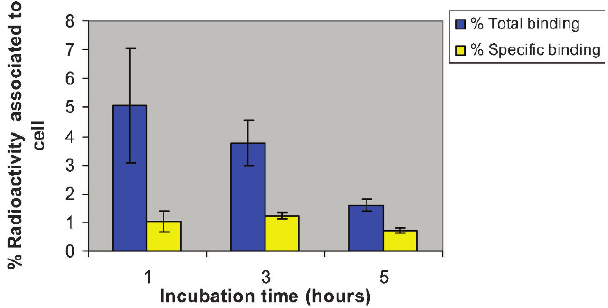
Figure 5 - Receptor binding to PC-3 cells of (SA + B-MORF + B- b Ala- BBN) with 99m Tc-MAG 3 -cMORF.